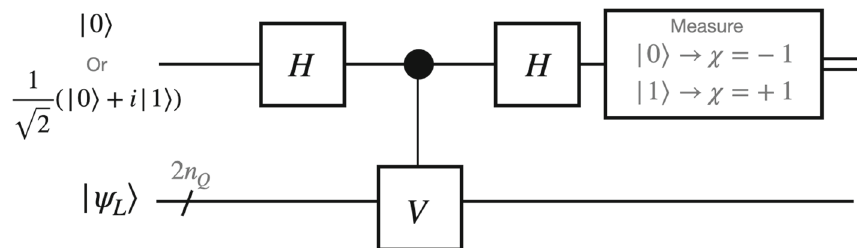
Fig. 3 Circuit representation of the measurement